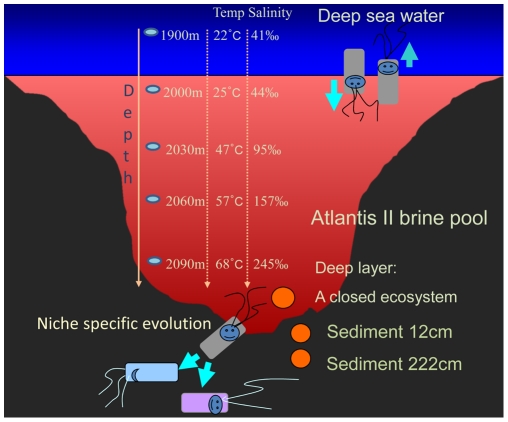
Schematic of the Atlantis II Deep brine pool and hypothetical bacterial niche-specific evolution.The figure briefly describes the vertical changes of the temperature and salinity in the Atlantis II Deep brine pool. Brine water and a sediment core were collected from the deep layer of the brine pool and the seafloor, respectively. Microbial samples were then obtained at depths of 12 cm and 222 cm from the core. Free microbe exchanges occur at the interface of the seawater and brine pool, all under natural selection; the microbial lineages in the deep layer (a closed ecosystem) heavily evolve during their adaptation to the sediment.